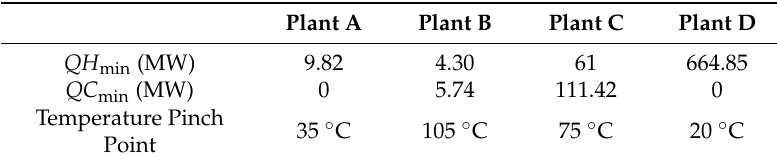
Table 6. Summary of PTA for Industrial Plants A to